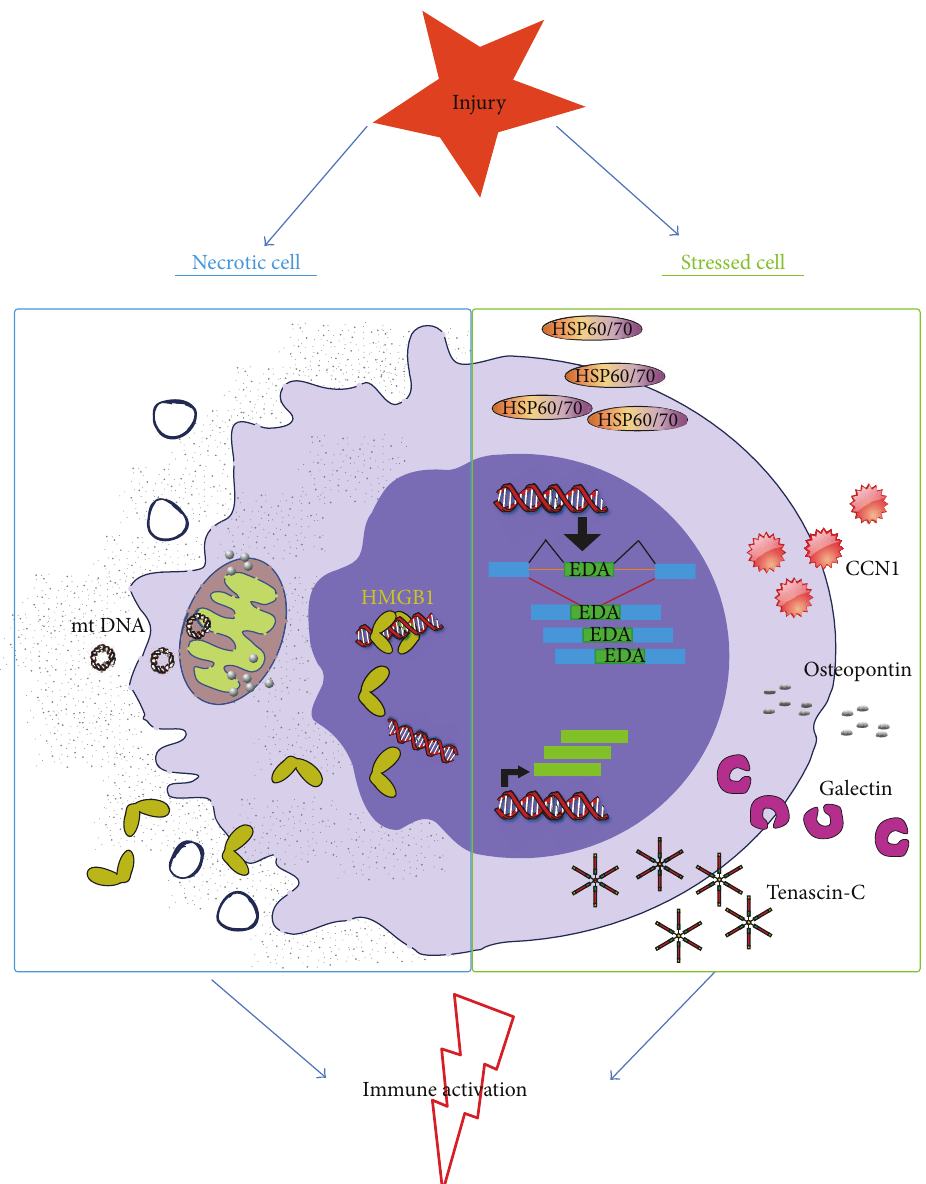
Figure 2: Proposed simplified mediators of danger signal release during myocardial infarction. Necrotic cells in the myocardium are leaky and release a subset of DAMPs, for instance, mtDNA and the DNA binding protein HMGB1. Furthermore, viable cells get stress signals from their surroundings and start to produce and secrete a range of proteins. These cells start the production of the EDA splice variant of fibronectin, HSPs and the matricellular proteins CCN1, osteopontin, galectins, and tenascin-C. Both the proteins released by necrotic cells and the produced proteins by stressed cells are able to activate or aggravate the immune response in the heart following